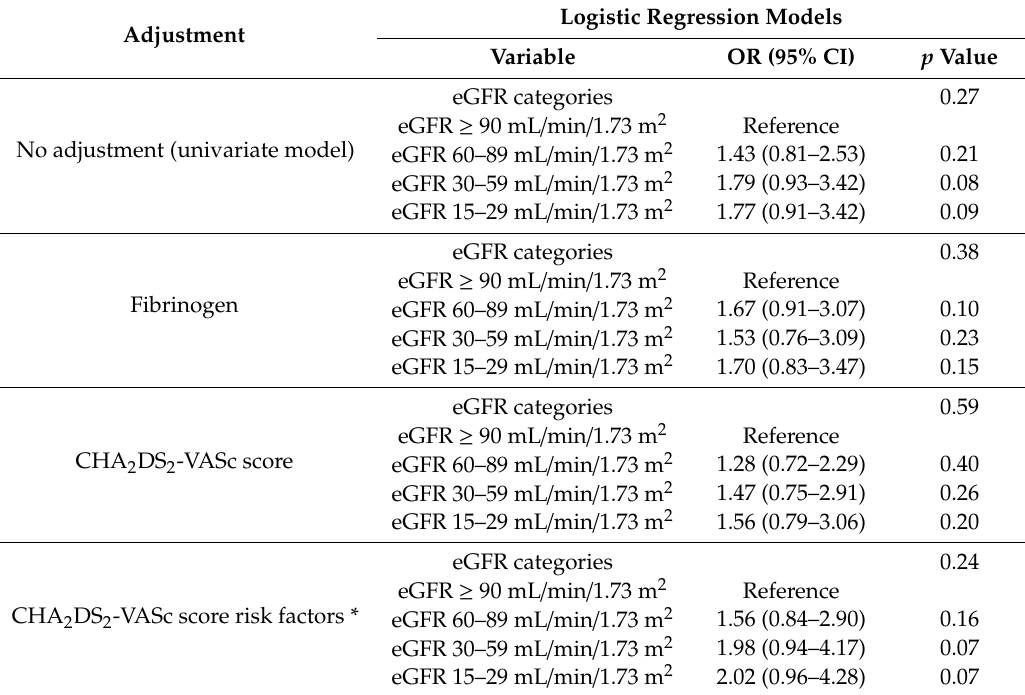
Table 4. Estimated glomerular filtration rate categories as predictors of low clot permeability (the lowest quartile, ≤ 6.0 × 10 − 9 cm 2 , n = 130).